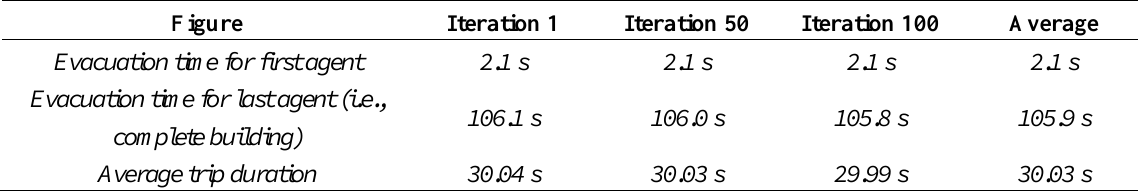
Table 3. Evacuation time statistics: Scenario 2. Figure Iteration 1 Iteration 50 Iteration 100 Average Evacuation time for first agent 2.1 s 2.1 s 2.1 s 2.1 s Evacuation time for last agent (i.e., complete building)